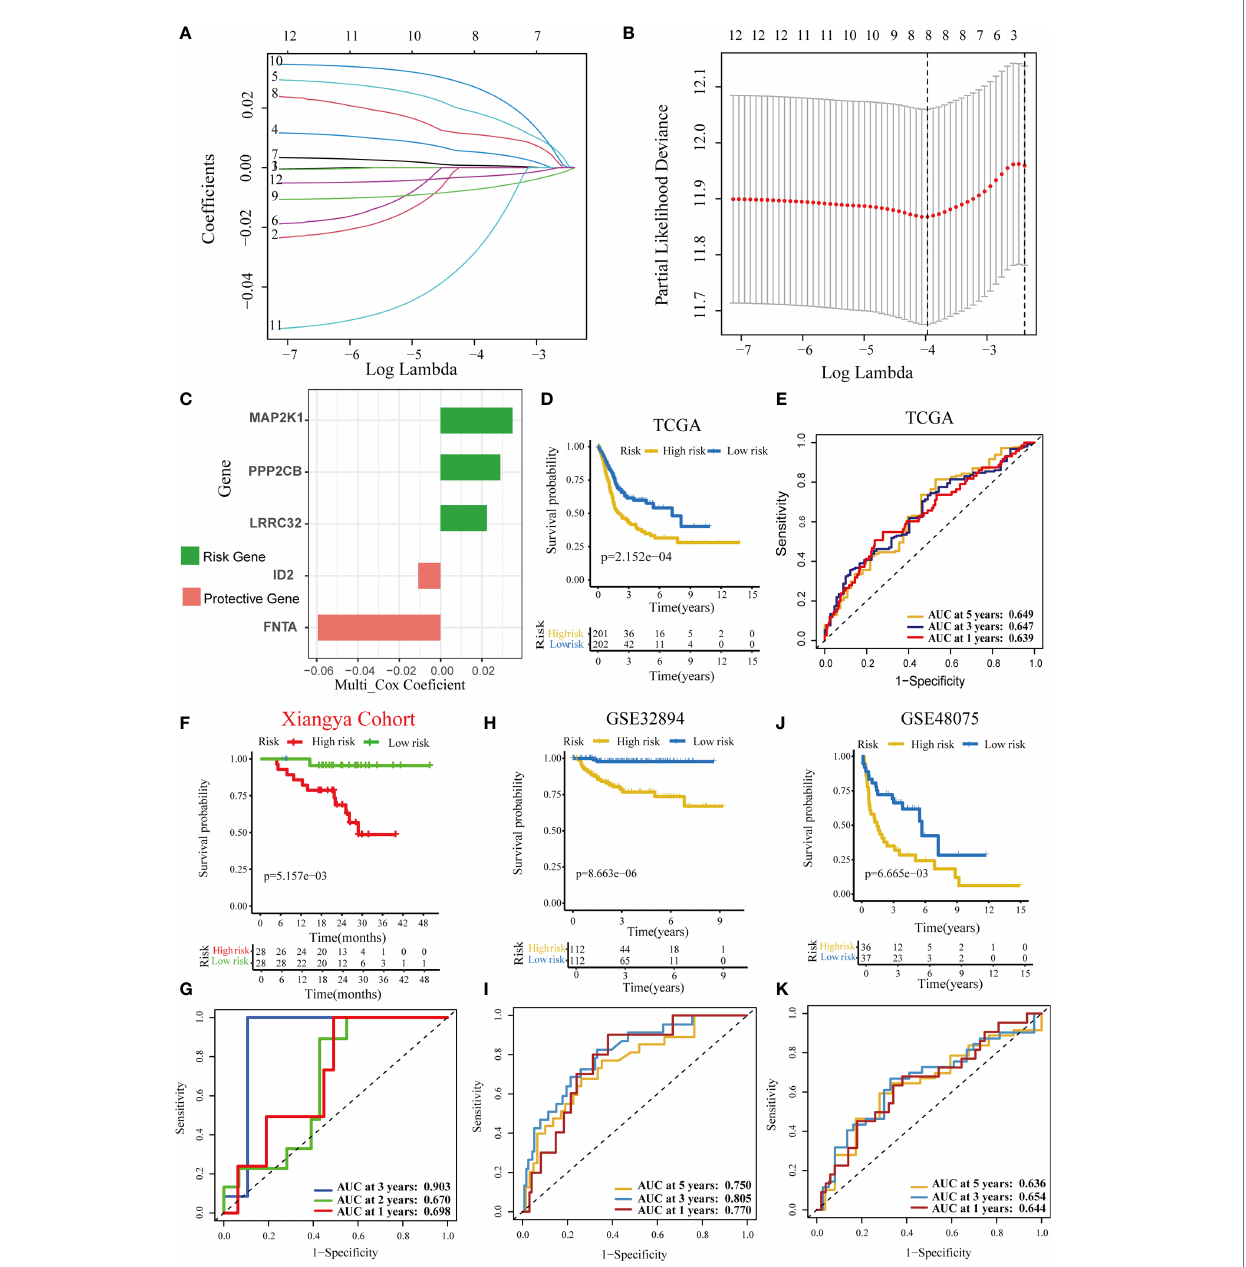
FIGURE 1 | Development and validation of a TGF- b risk score in several BLCA cohorts. (A) LASSO coef fi cients of 12 prognostic TGF- b genes in the TCGA-BLCA cohort. (B) Cross-validation for turning parameter selection via minimum criteria in the LASSO regression model. (C) The coef fi cients of fi ve optimal TGF- b genes included into the fi nal multivariate Cox analysis. Green indicates the risk gene, while red represents the protective gene. (D) Kaplan – Meier analysis of OS for TGF- b risk score in the TCG-BLCA cohort. (E) ROC curves of the TGF- b risk score in predicting OS in the TCG-BLCA cohort. (F, G) Validation of the TGF- b risk score in the Xiangya cohort. (H, I) Validation of the TGF- b risk score in GSE32894. (J, K) Validation of TGF- b risk score in the